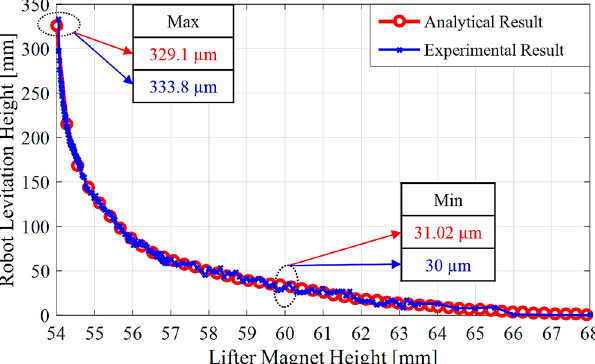
Figure 11. Finite element method (FEM) analysis and experimentally compared levitation heights according to lifter magnet height. Accordingly, it is seen that the obtained levitation characteristics are very close to each other.